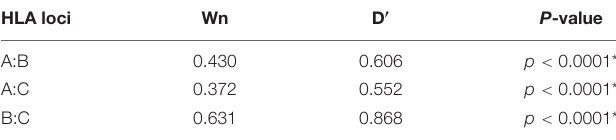
TABLE 2 | Global pairwise linkage